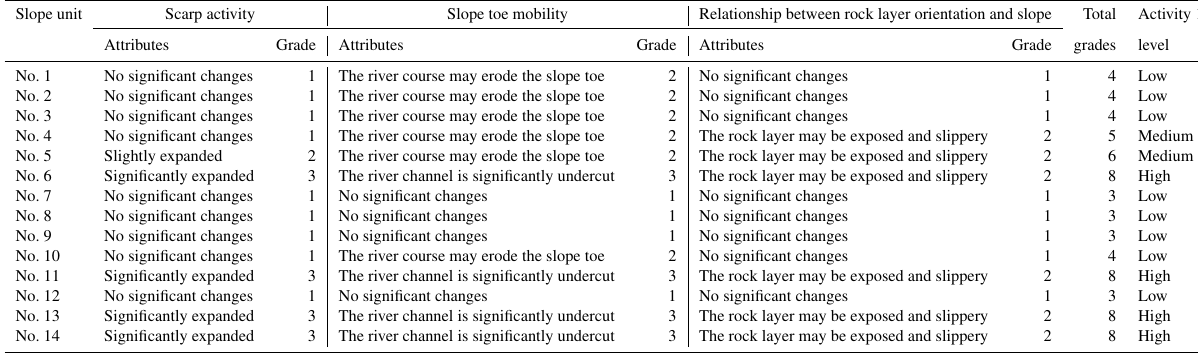
Table 13. Grades and levels of Activity 1 of slope unit around the Neikuihui tribe.